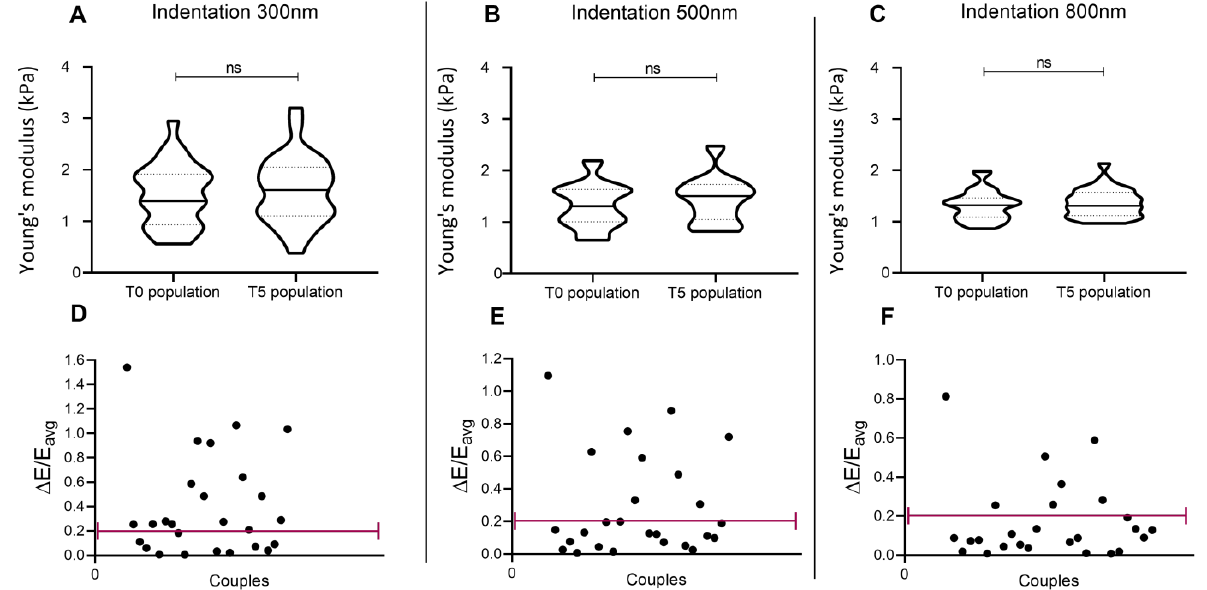
Figure 6. Indentation repeated in the same site of a single cell, 5 min after the first indentation (line 7). Panel ( A – C ): Distribution of elasticity values in the cell population, when indentation is performed at 300, 500, and 800 nm. ( D – F ): Normalized difference between elasticity values of each cell, obtained from the two consecutive indentations.